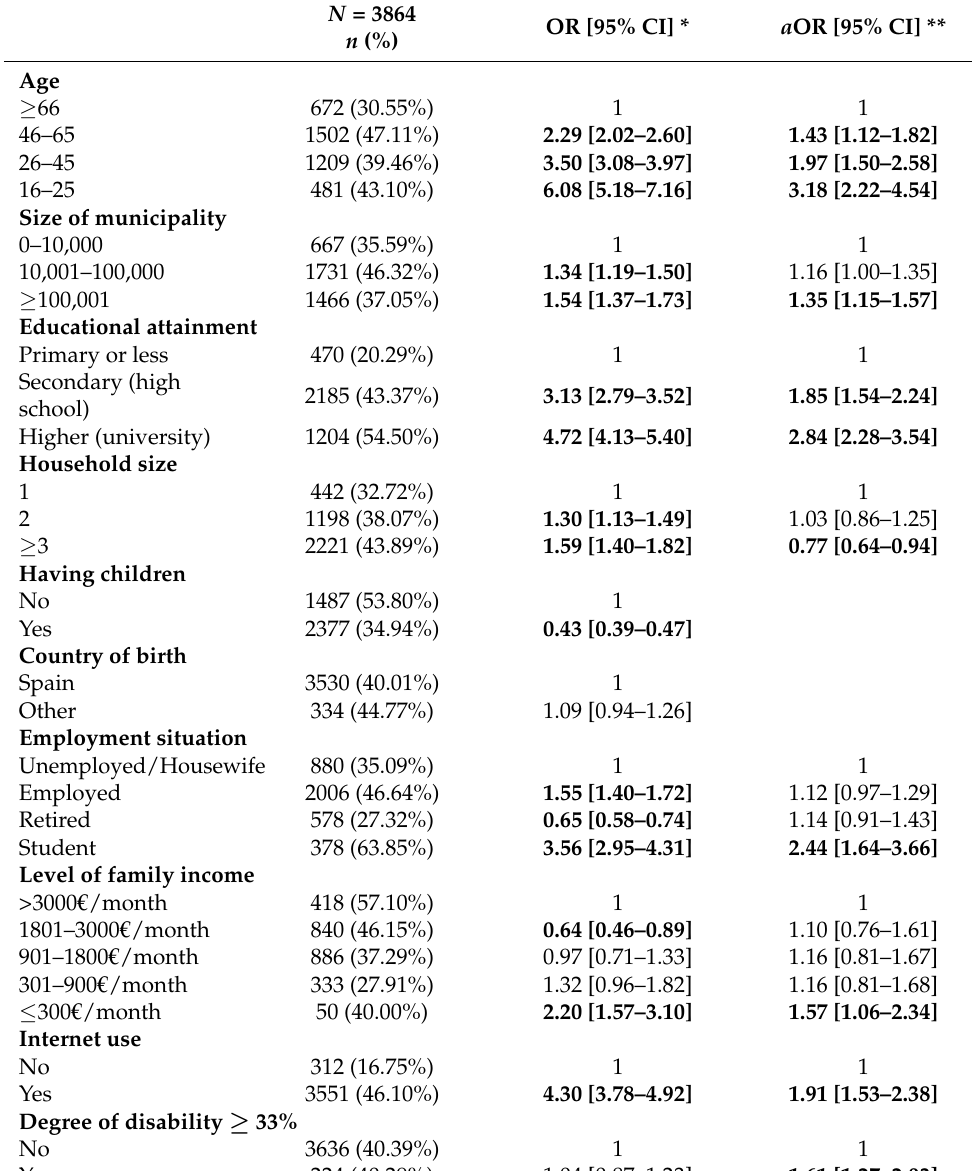
Table 3. Association between sociodemographic characteristics and